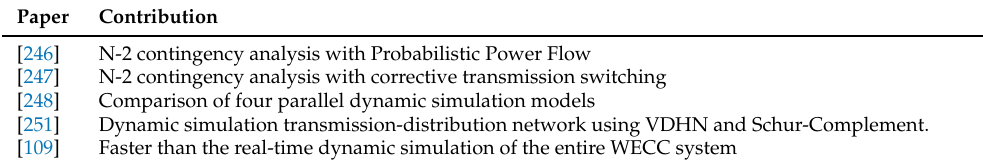
Table 6. Power System Stability MIMD-based state-of-the-art studies.